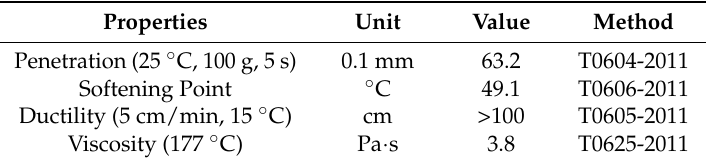
Table 1. Properties of 70-Penetration asphalt.